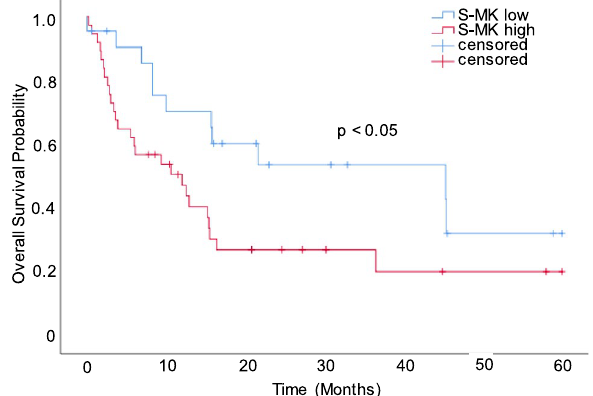
Figure 8. NSCLC patients with low S-MK expression show a longer overall survival than patients with high S-MK expression. Abbreviations: S-MK serum-midkine, NSCLC non-small lung cancer. Kaplan–Meier curve comparing overall survival of NSCLC patients with low (S-MK < 6.71 log pg/ml; n = 22) and high S-MK levels (S-MK ≥ 6.71 log pg/ml; n = 37). Patients were followed up for 5-years post-surgery. Statistical difference was determined using the log-rank test (p < 0.05).